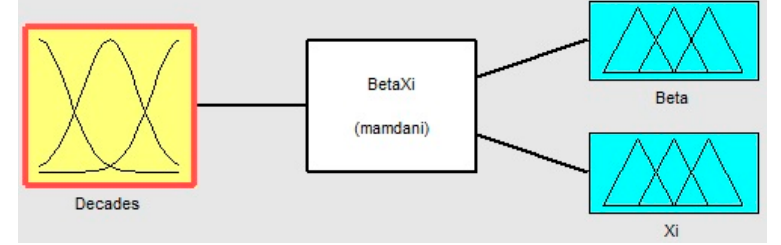
Figure 11. FICA combination β and ξ .